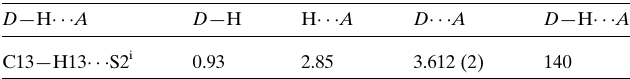
Table 1 Hydrogen-bond geometry (A˚ , (cid:2) ).